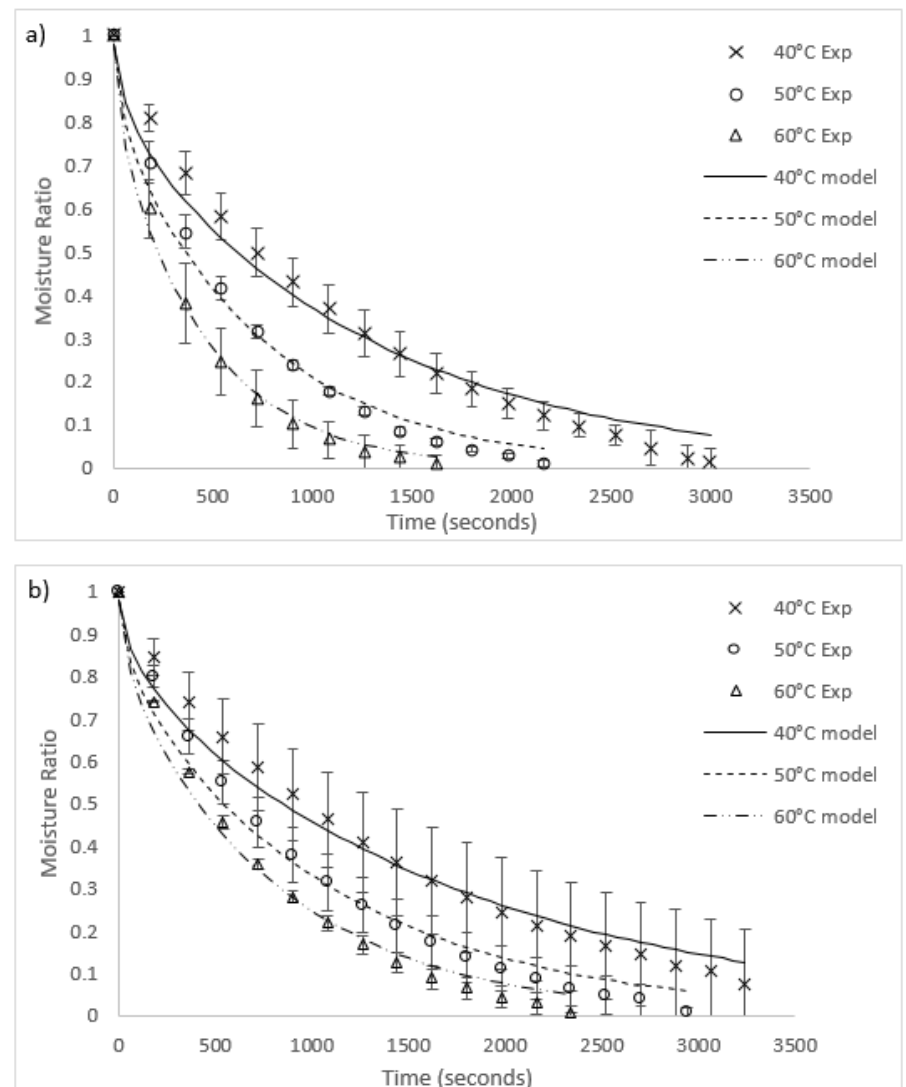
Figure 3. Comparison of radiation drying results and models for ( a ) U. ohnoi and ( b ) O. intermedium (Exp = experimental; model = modelling outcome).